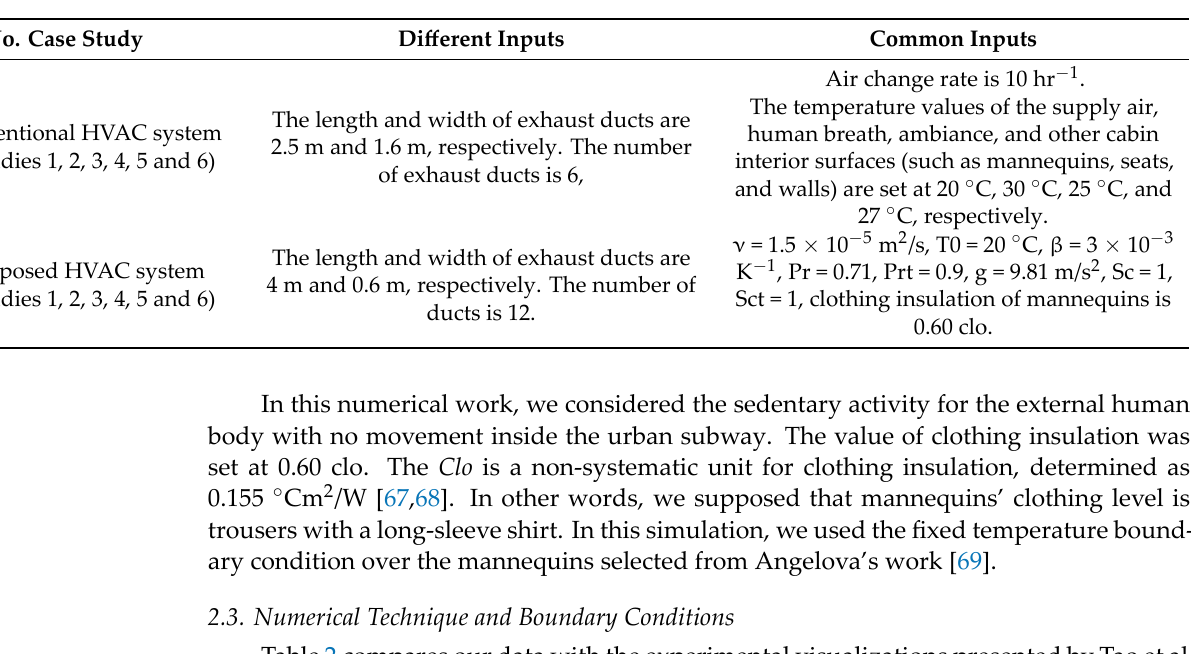
Table 1. The main characteristics of the evaluated case